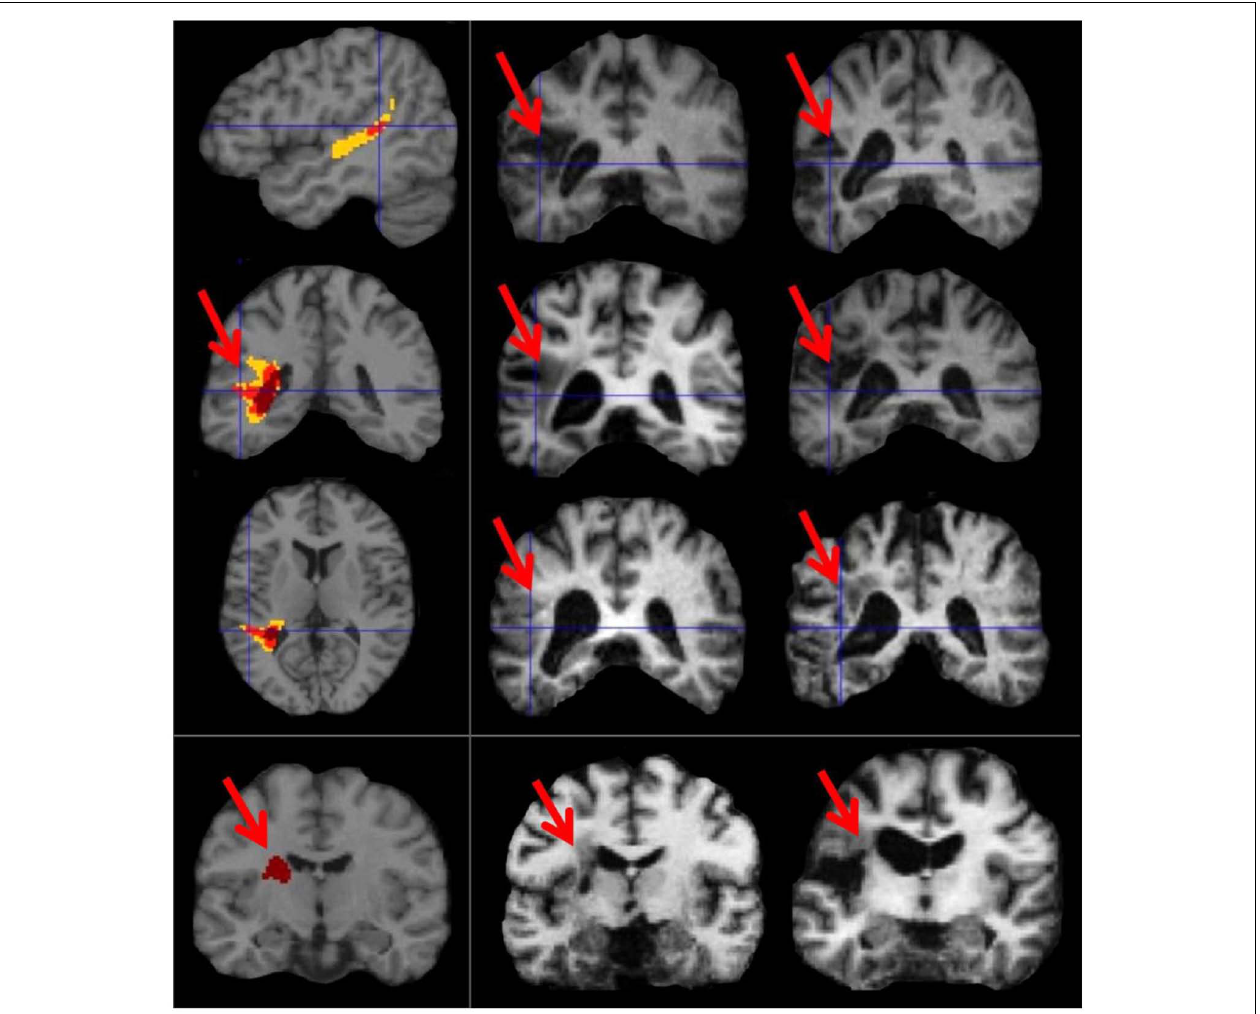
FIGURE 4 | Lesion sites in patients with selective repetition difficulties. These images illustrate the most consistent lesion sites in patients with selective repetition difficulties.The left column shows overlap maps.The first three rows of the left column show overlap maps of sagittal ( x = − 40), coronal ( y = − 40), and axial slices ( z = + 10) for six patients projected onto the canonical brain in MNI space.To the right, these six patients are represented by coronal sections of their individual anatomical brain images in normalized space (in the middle and right columns of rows 1, 2, and 3).The bottom row